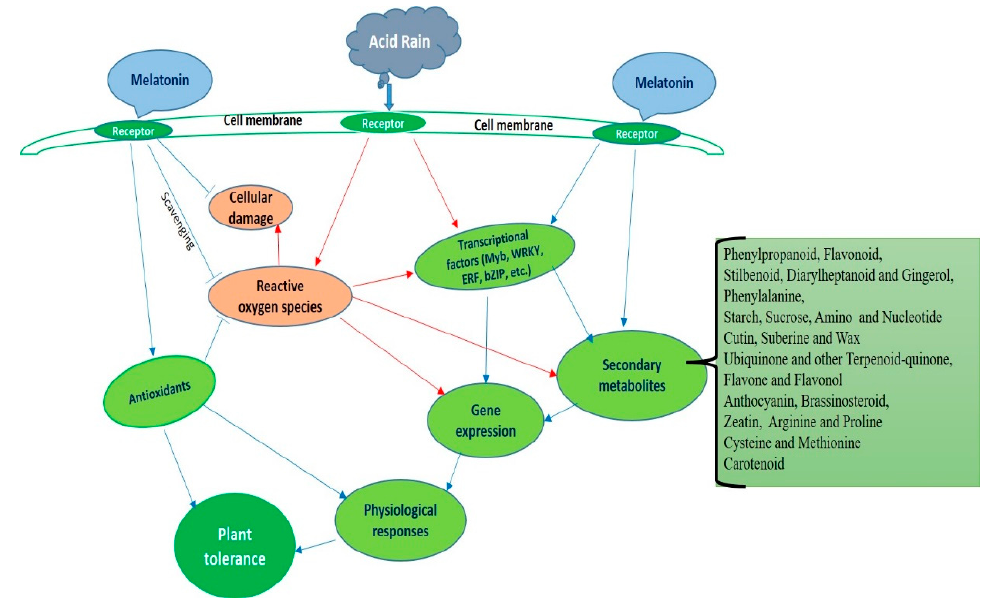
Figure 3. Melatonin-mediated acid rain stress tolerance and detoxification mechanism in plants. Modified from Debnath et al. [18].